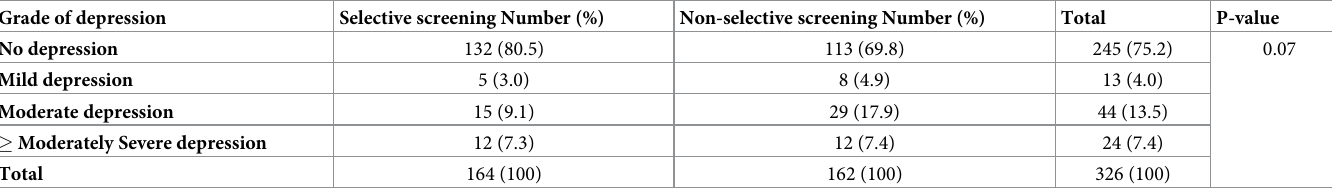
Table 2. Grading of cases of depression detected by non-selective or selective screening as measured by the PHQ9 among 326 participants at Princess Diana Memo- rial Health Centre IV, Soroti District, April to June 2018. Grade of